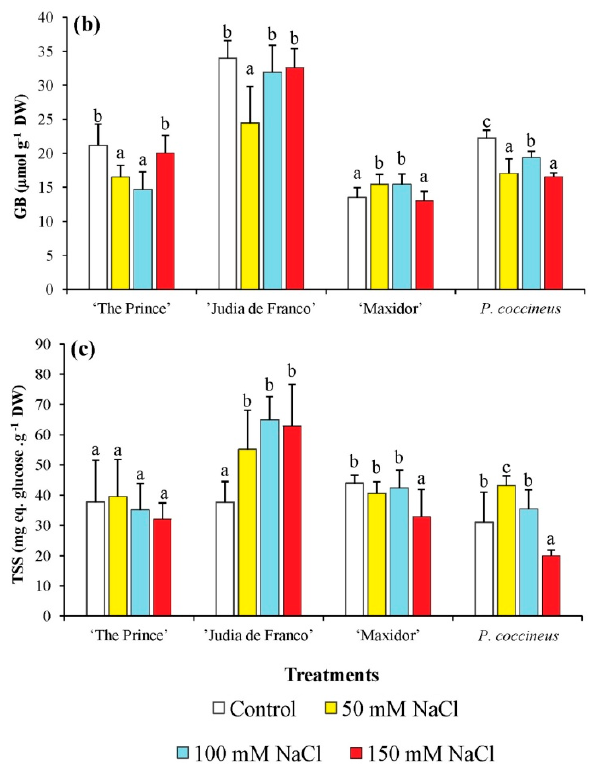
Figure 3. Salt stress-induced changes in the levels of osmolytes of 5-week-old Phaseolus plants. Salt stress-induced changes in the levels of: ( a ) proline (Pro); ( b ) glycine betaine (GB); and ( c ) total soluble sugars (TSS) in the same samples as in Figure 2. Measurements were performed after three weeks of treatment. The values shown are means with SD ( n = 5). For each cultivar, different lowercase letters indicate significant differences between treatments according to the Tukey test ( α = 0.05).